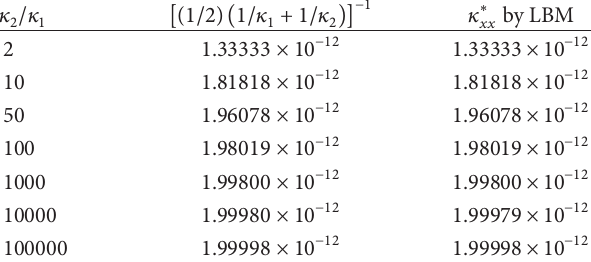
Table 1: Verification of computed 𝜅 ∗ 𝑥𝑥 , 𝜅 1 = 10 −12 m 2 and ] eff =